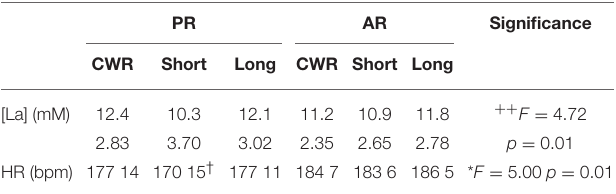
TABLE 3 | Mean ± SD values of the blood lactate concentration ([La]) and heart rate (HR) during the constant-work-rate (CWR) and intermittent exercise conditions (Short and Long), for passive (PR) and active (AR) recovery groups. PR AR